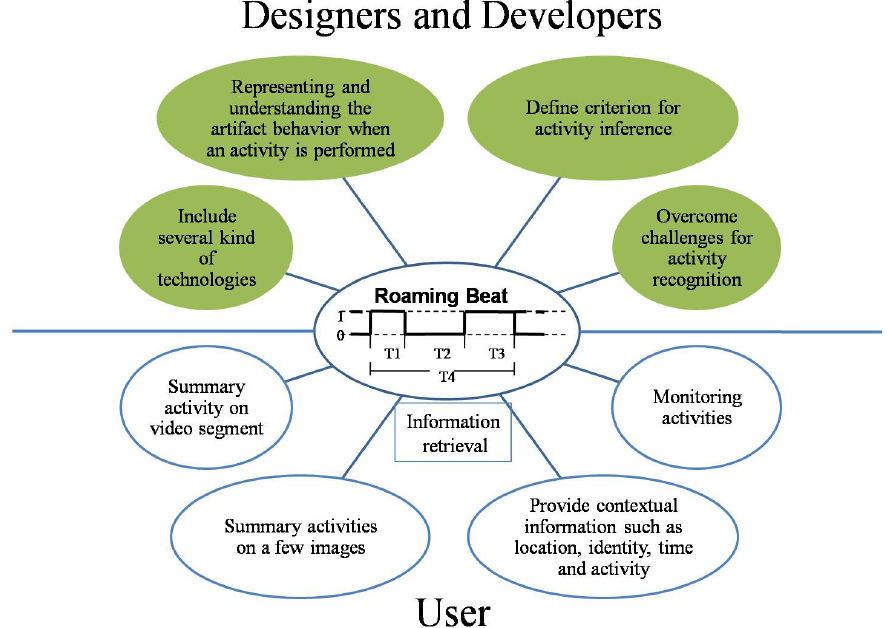
Figure 12. Roaming beat vision focused on designers, developers and